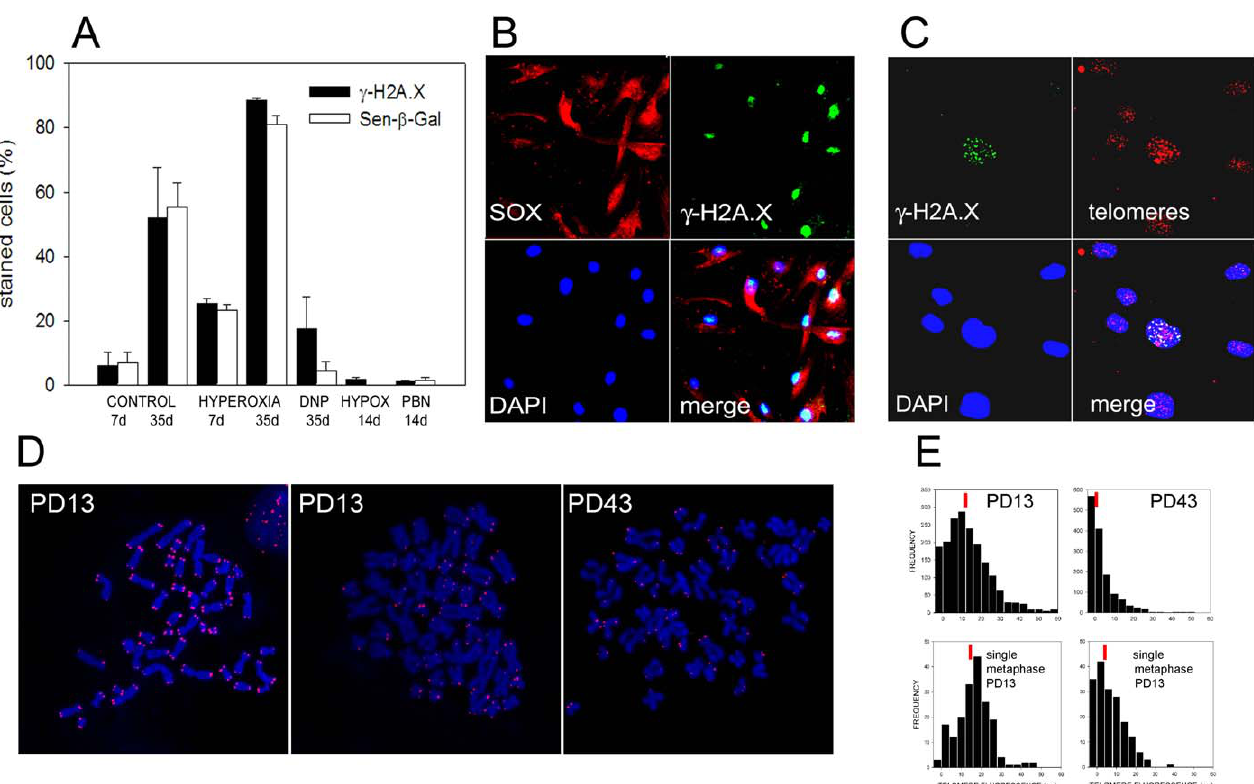
Figure 5. Cell-to-Cell Heterogeneity in Replicative Senescence: Involvement of Mitochondrial ROS and Telomeres (A) The frequency of senescent cells as measured by c -H2A.X (filled bars) or Sen- b -Gal (open bars) staining is time- and oxidative stress–dependent. Experiments started at PD 38, and cells were grown for the indicated time under either 21% oxygen (CONTROL), 40% normobaric oxygen (HYPEROXIA), normoxia þ 250 l M DNP (DNP), 5% normobaric oxygen (HYPOX), or normoxia and 400 l M PBN (PBN). Data are mean 6 s.e.m., n (cid:3) 3. (B) Cells with high mitochondrial superoxide production are c -H2AX positive. Cells were stained with MitoSOX, photographed, and then fixed and immunostained for c -H2A.X; then the same area was photographed again and merged. (C) ImmunoFISH in an actively growing MRC5 culture shows frequent co-localization (yellow) between c -H2A.X foci (green) and telomeres (red) in those cells that do contain foci. This co-localisation is significant according to a Pearson correlation analysis (see Figure 6H). (D) Telomere Q-FISH of metaphases from young (left and middle) and near-senescent (right) MRC5 cultures. A few metaphases from young cultures show weak telomeric signals (middle image) similar to typical metaphases from a near-senescent culture (right image). (E) Cumulative Q-FISH telomere frequency histograms from a young (PD 13, top left) and a near-senescent (PD 43, top right) population together with histograms from two individual metaphases at PD 13 (bottom). Metaphases of the near-senescent type (bottom right) are found with low frequency ( , 10%) in young